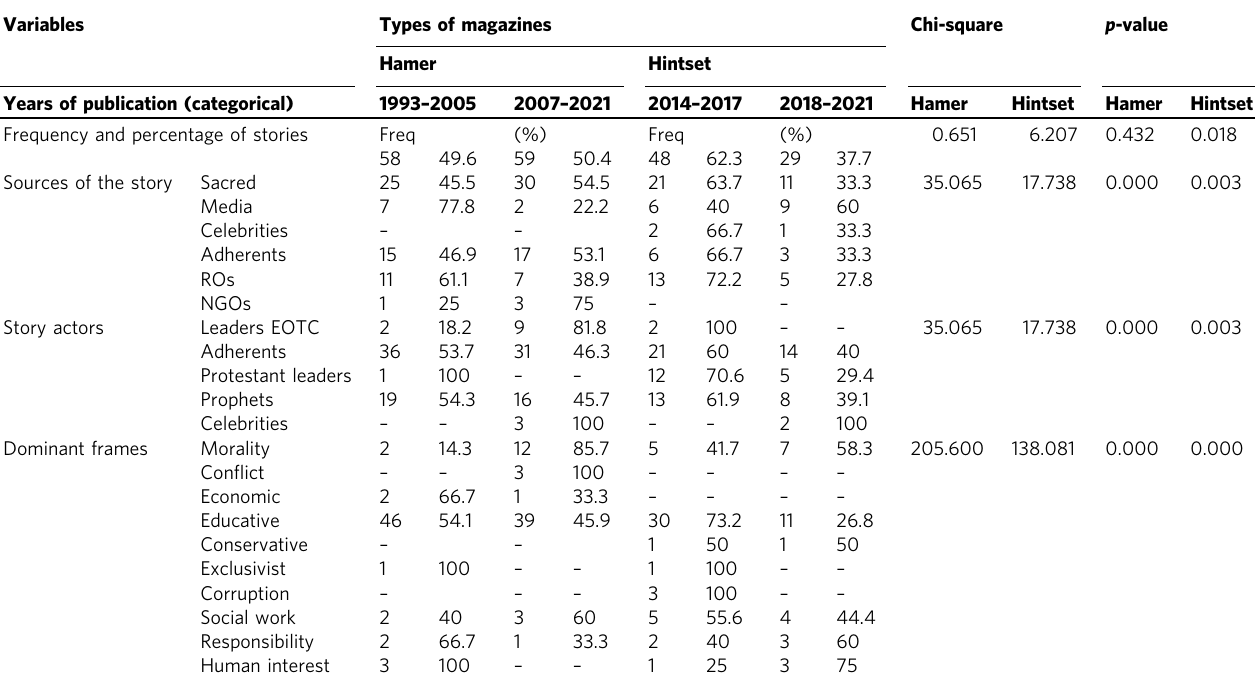
Table 2 Cross-tabulation: Social development * Types of publication * Years of publication * Sources * Story actors * Dominant